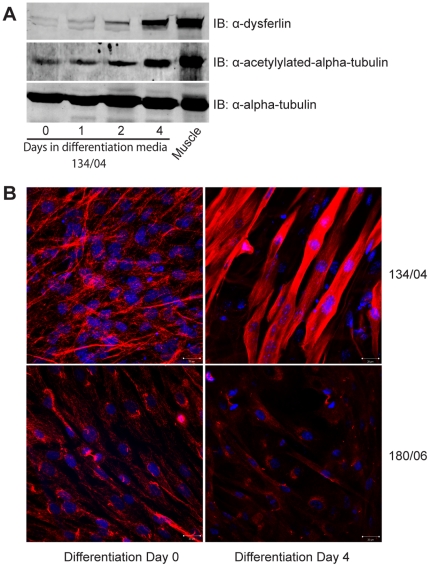
Dysferlin and acetylated alpha-tubulin levels increase during differentiation.(A) 134/04 cells were cultured in differentiation media for the indicated number of days. Cell lysates from these cells and mouse skeletal muscle extract were immunoblotted with the indicated antibodies. (B) 134/04 cells and 180/06 cells were cultured in differentiation media for 0 days or 4 days to induce myotube formation. Cells were fixed and immunostained with anti-acetylated alpha-tubulin antibodies and DAPI. Images were captured at the same fluorescence intensity and gain to compare alpha-tubulin acetylation levels between cells. Scale bar: 20 µm.